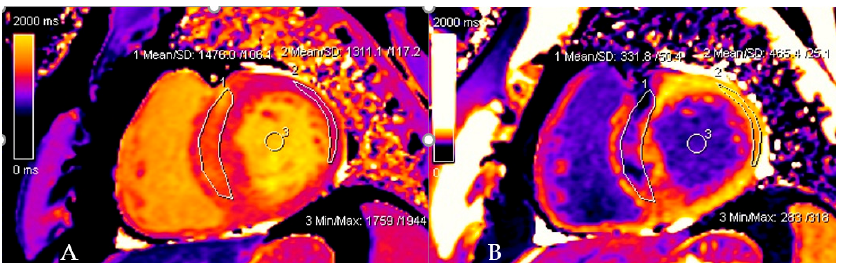
Figure 1. Late gadolinium enhancement (LGE) images show the quantification of the septal burden of replacement fibrosis (circled) via the technique which uses a 5-standard-deviations threshold on consecutive short-axis slices.